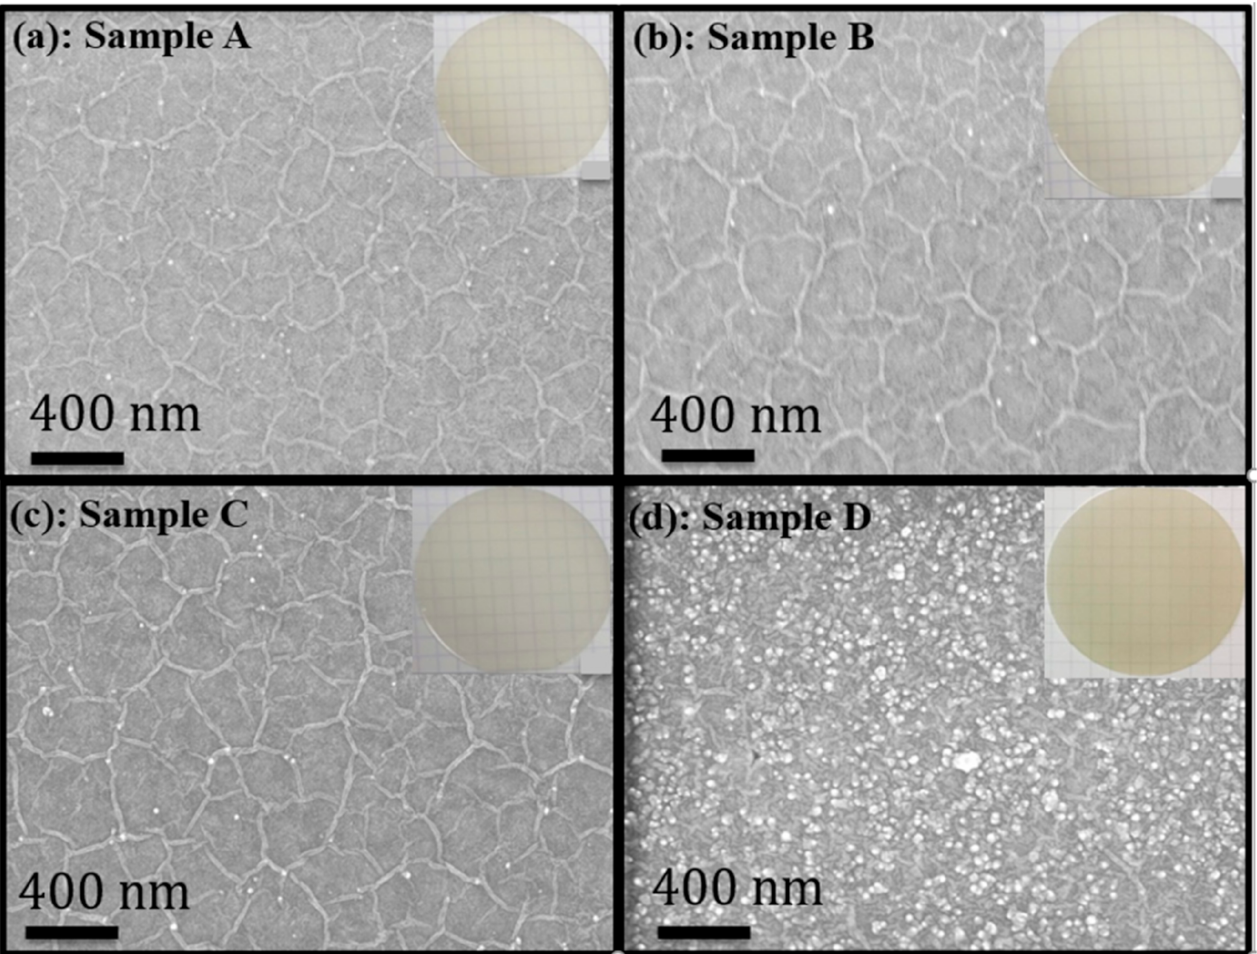
Figure 1. ( a – d ) SEM images of h-BN samples A, B, C and D, respectively. Insets show photographs of the respective